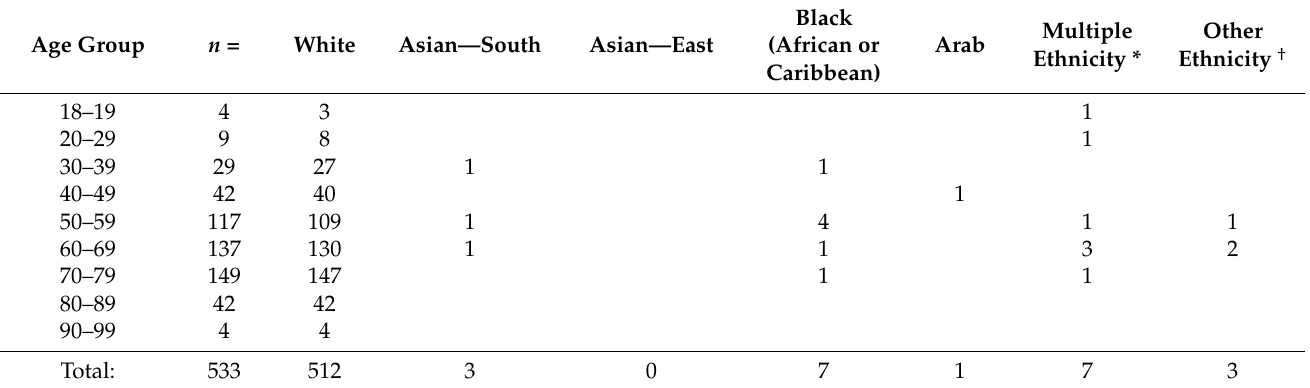
Table 1. Descriptive statistics: Ancestry by age group (females, n = 533).